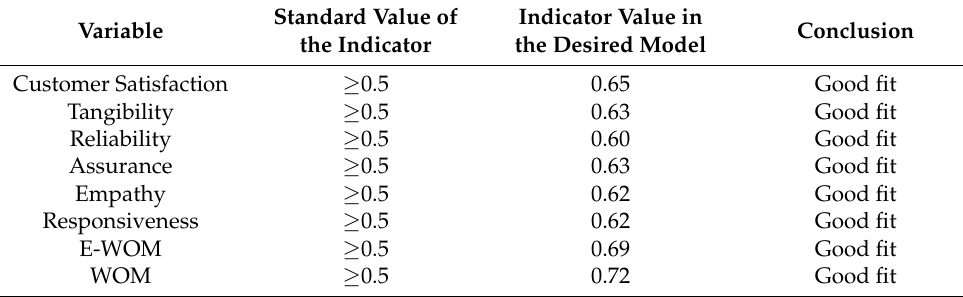
Table 2. Average variance extracted (AVE).